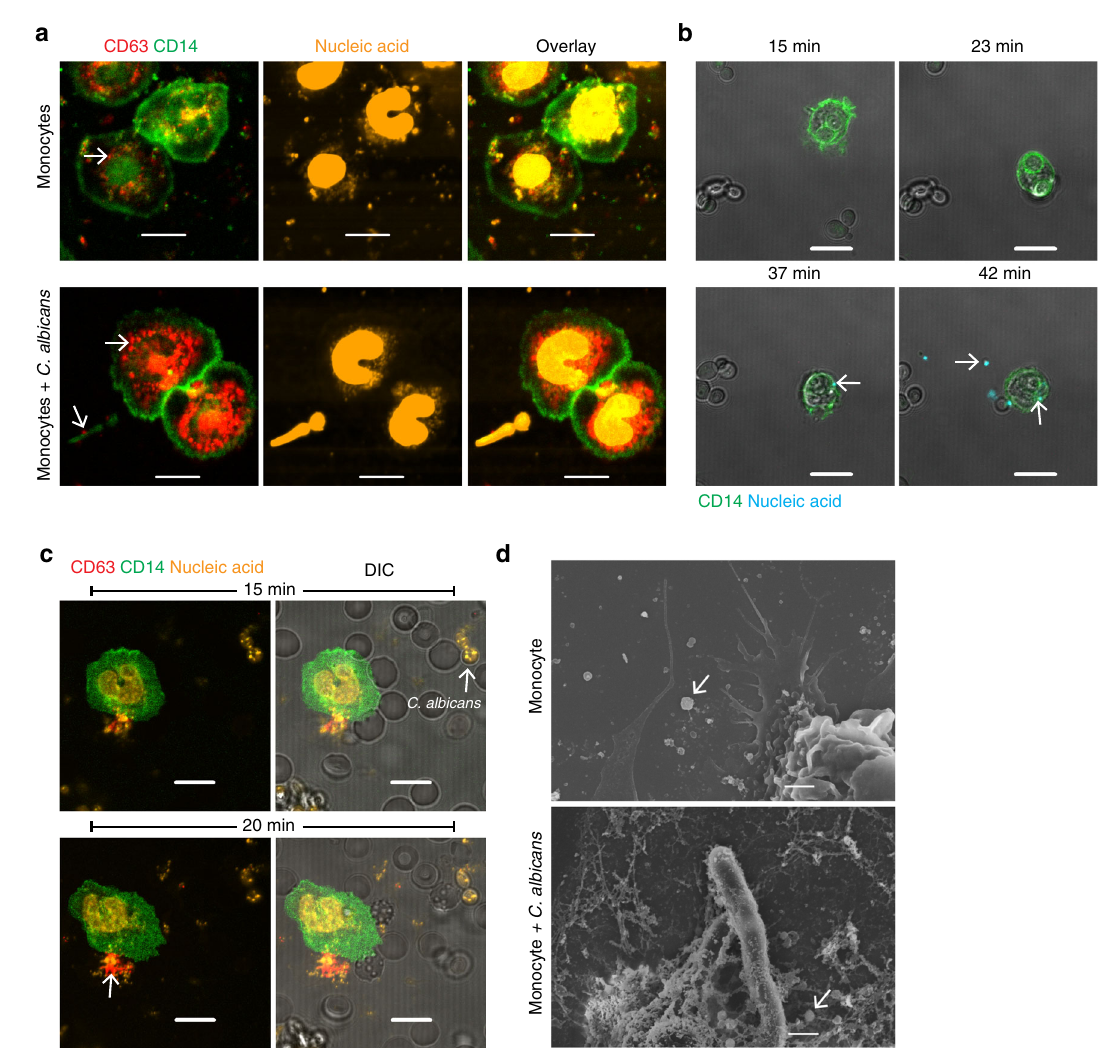
Fig. 1 C. albicans induces vesicle release from human blood monocytes. a Vesicle formation (arrow) increases in C. albicans -infected monocytes using confocal laser-scanning microscopy (CLSM). Staining – red: CD63, green: CD14, and orange: nucleic acids after 1 h of co-incubation. Bars: 5 µ m. Representative data of fi ve independent experiments are shown. b Release of EVs from the infected monocytes visualized by live cell imaging using CLSM. After phagocytosis (23 min) of C. albicans , the EVs (42 min) (arrows) are released. Staining – green: CD14 and cyan: nucleic acids. Bars: 10 µ m. Representative data of three independent experiments are shown. c Infected monocytes in an ex vivo whole-blood model show early (20 min) release of MEVs Ca (arrow) by live cell imaging (CLSM). Staining – red: CD63, green: CD14, and orange: nucleic acids. Bars: 10 µ m. Representative data of fi ve independent experiments are shown. d Scanning electron microscopy (SEM) con fi rms the presence of MEVs and MEVs Ca released by untreated and infected monocytes (arrows) respectively. Bars: 1 µ m. Representative data of three independent experiments are